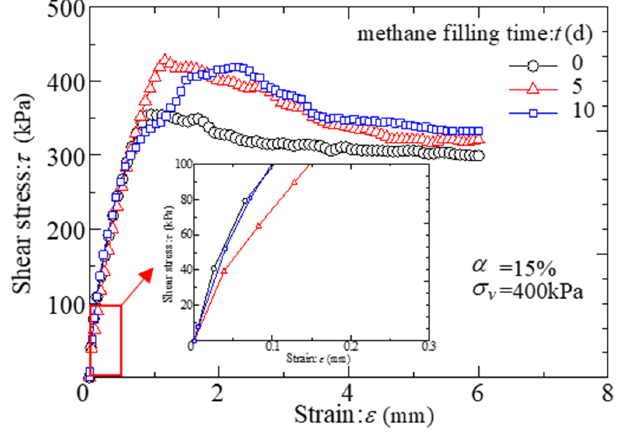
Figure 4. Stress–strain curves of biochar–clay mixed soil under various aeration times.